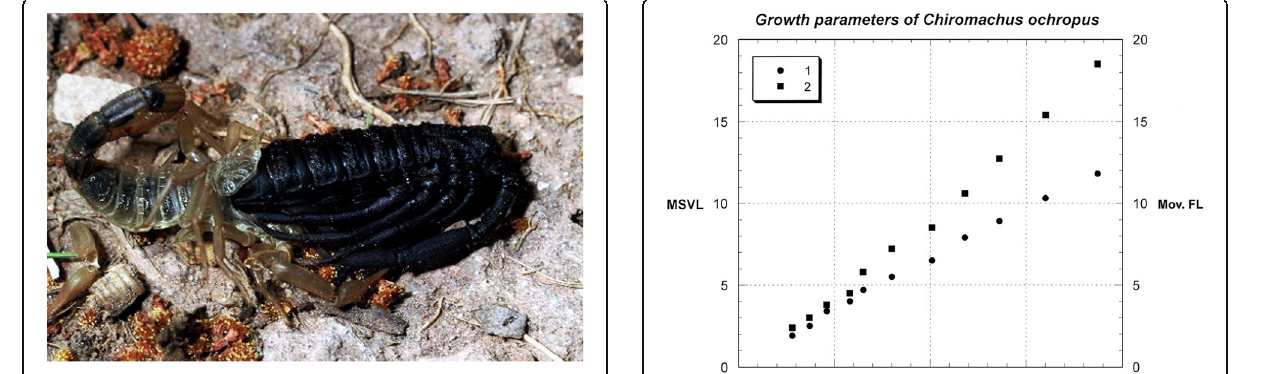
Fig. 16 Molting process in the buthid scorpion Hottentotta franzwerneri from North Africa